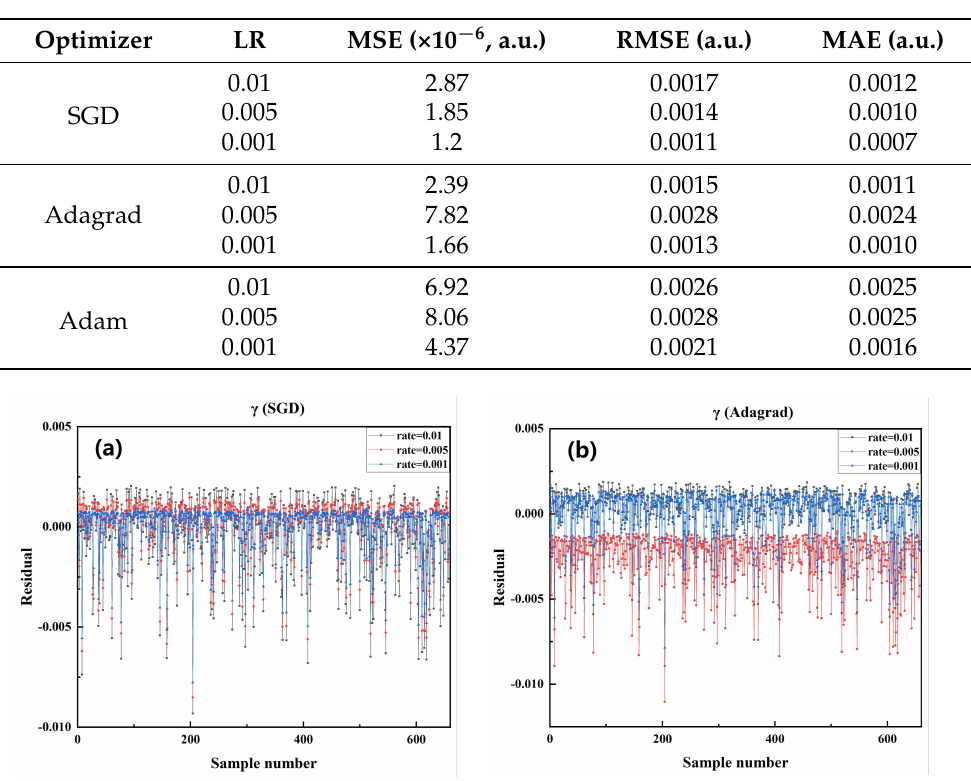
Figure 7. Comparison of the residual between the predicted value and the actual value of γ in the test data set of the model trained by each algorithm under different learning rates in SGD optimizer and Adam optimizer. ( a ) SGD optimizer, LR: 0.01, 0.001, 0.005 ( b ) Adagrad optimizer, LR: 0.01, 0.001,